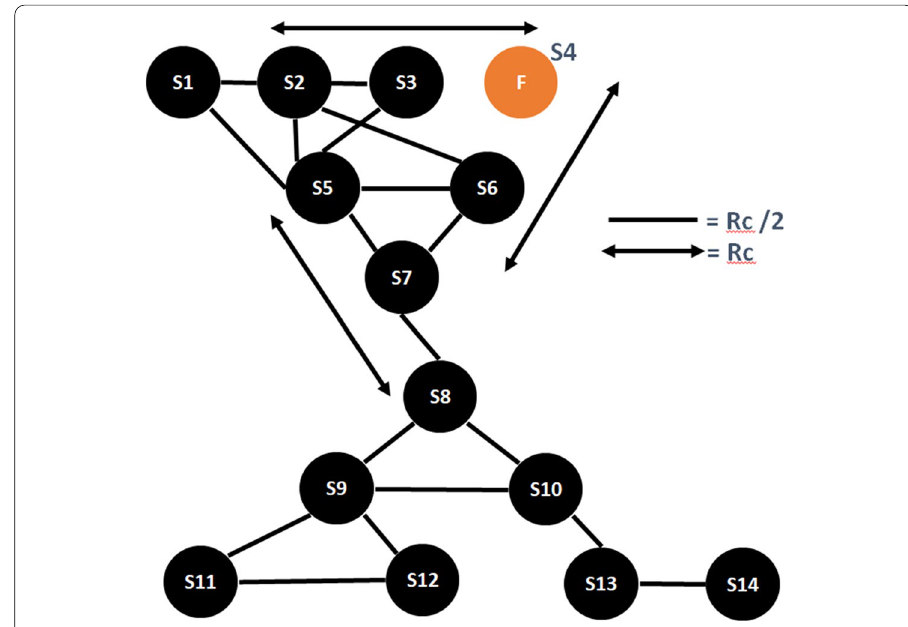
Fig. 3 End node failure